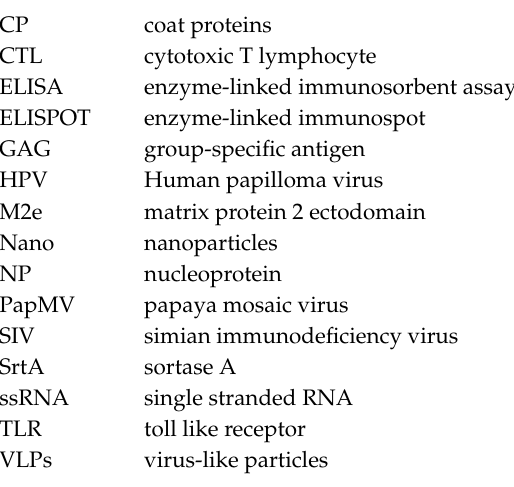
Figure S1: Characterization of the size and appearance of the PapMV nano coupled to the antigens; Figure S2: Assessment of the humoral response directed to the M2e